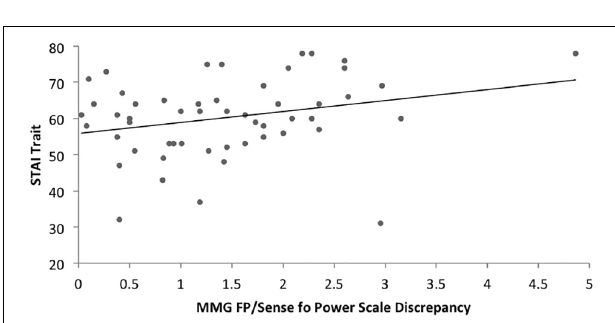
FIGURE 5 | Scatterplot of the correlation between the Fear of Losing Power (MMG)/Personal Sense of Power Scale discrepancy and trait anxiety in women with